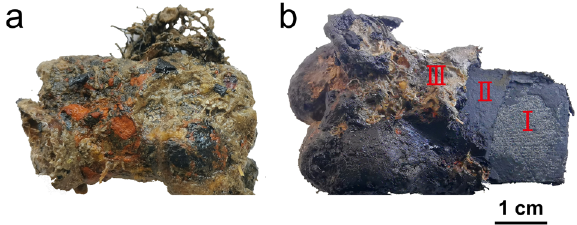
Fig. 1 Optical images of Q345 coupons after 5.5 years-immersion in Sanya nature sea water. a The overall appearance and b the pro fi le showing cross sections. (I) dark-green innermost layer (IL), (II) black middle layer (ML), (III) grey and red outermost layer